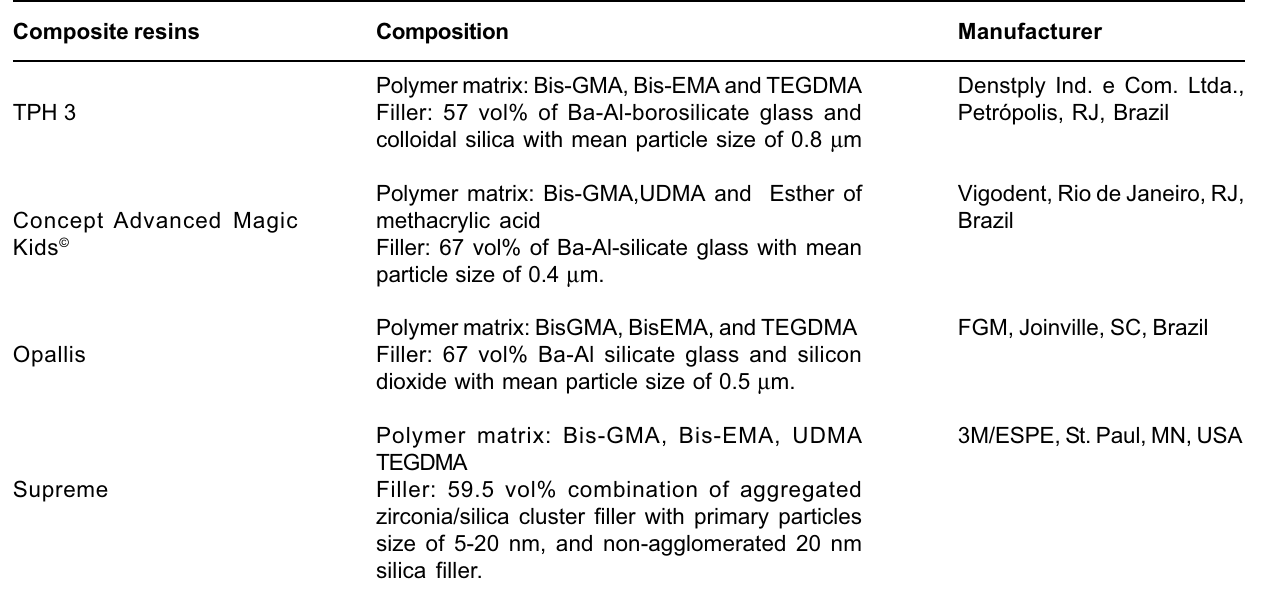
TABLE 1- Composition and specifications of composite resins used in this study